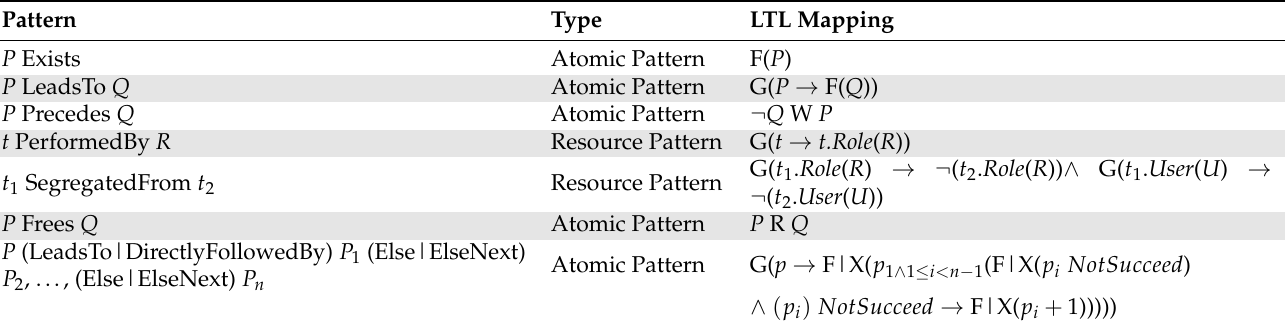
Table 6. Excerpt of CRL patterns (adopted from [33]).